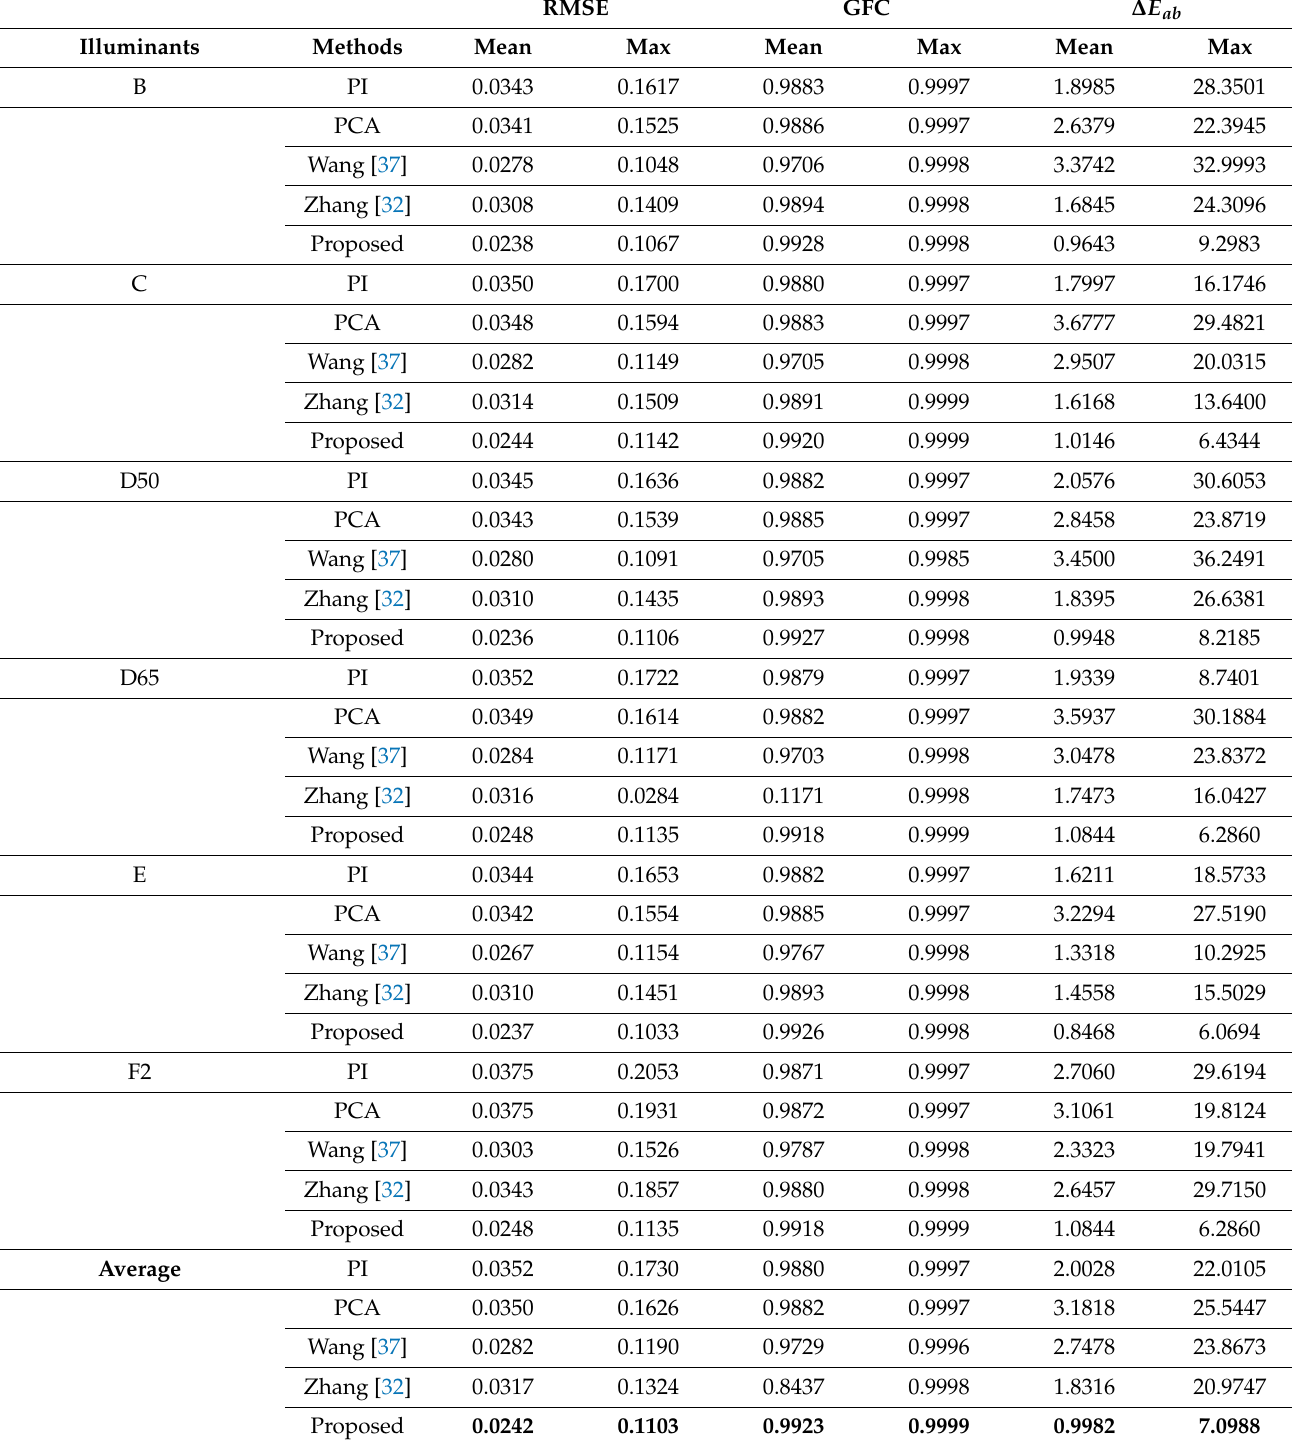
Table 7. Results of recovery spectral reflectance for different illuminants using different spectral recovery methods and Canon5D Mark II spectral sensitivity